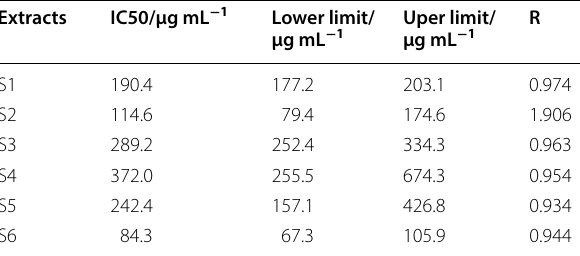
Table 2 Half inhibition ratios of S1–S6 (95% confidence limits) and the correlation coefficient R